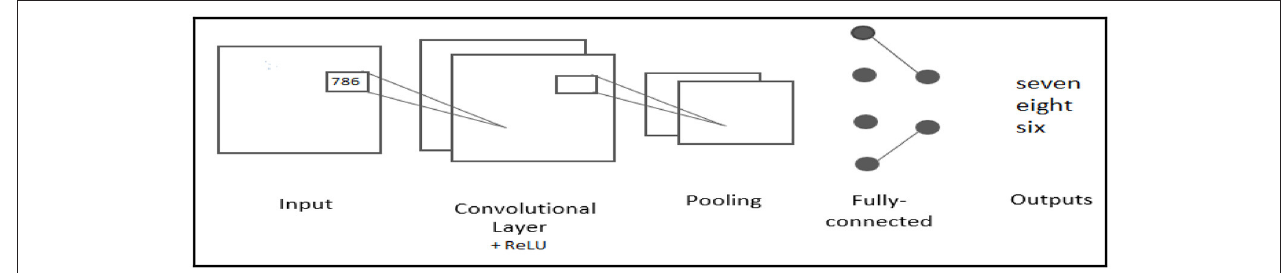
FIGURE 5 | CNN Architecture of Spoken Arabic digit to Text.